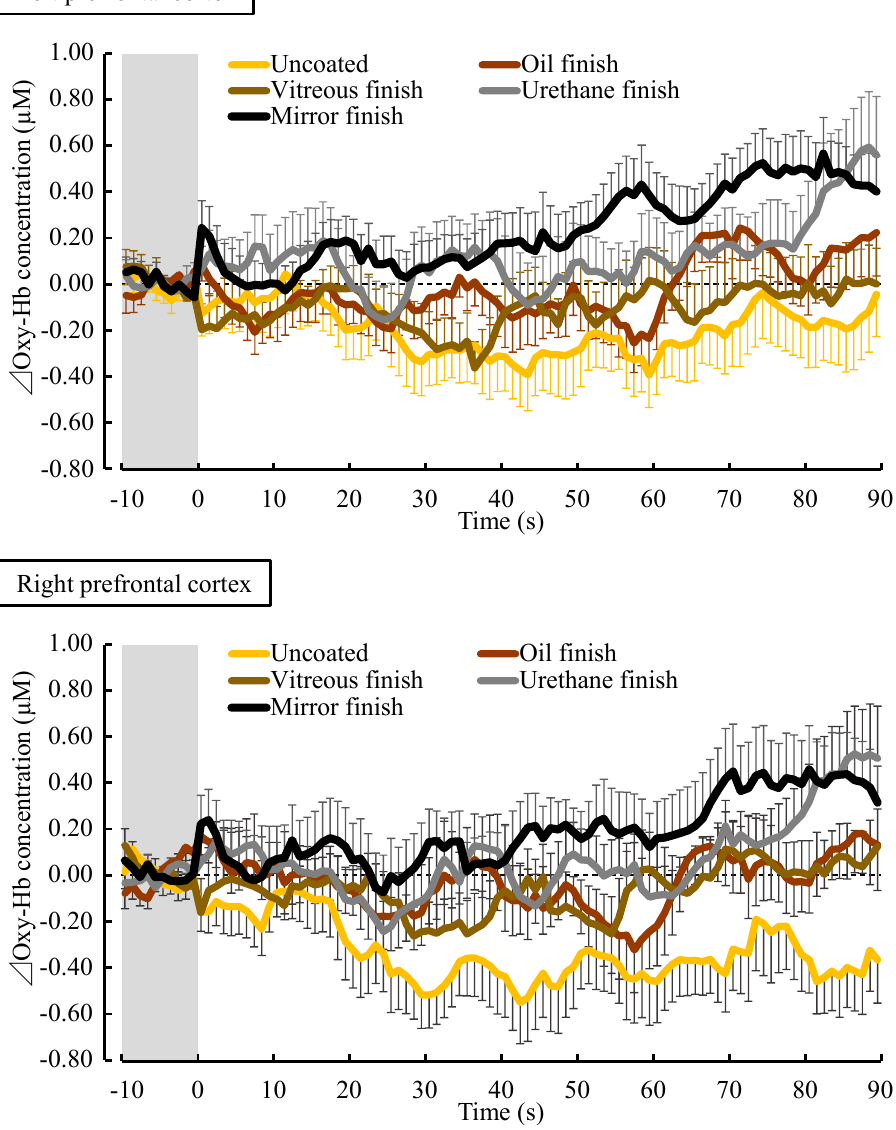
Figure 4. Changes in oxy-Hb concentration in the left and right prefrontal cortices every 1 s over 90 s while touching white oak wood (uncoated, oil finish, vitreous finish, urethane finish, and mirror finish). All data were calculated as the difference between the averages of the 10-s values before touching. Data are expressed as mean ± standard error, n = 18.